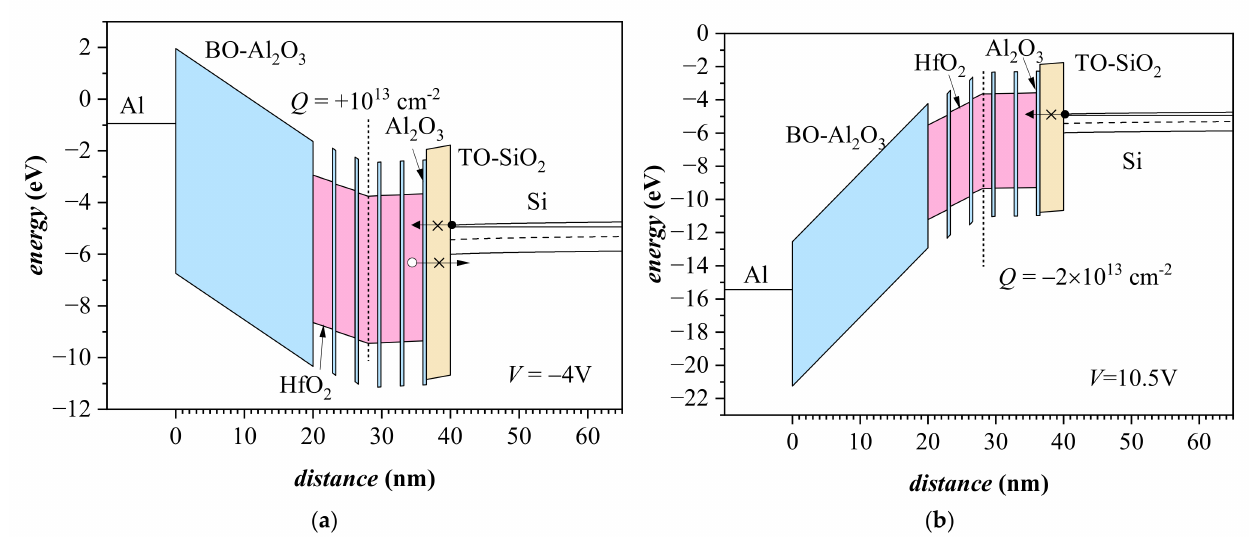
Figure 8. Band diagrams of capacitor with 3.5 nm SiO 2 TO layer with positive trapped charge at applied voltage of − 4 V ( a ), and ( b ) with negative trapped charge at V = 10.5 V. The trapped charge is roughly equal to the stored charges in the capacitor presented in Figure